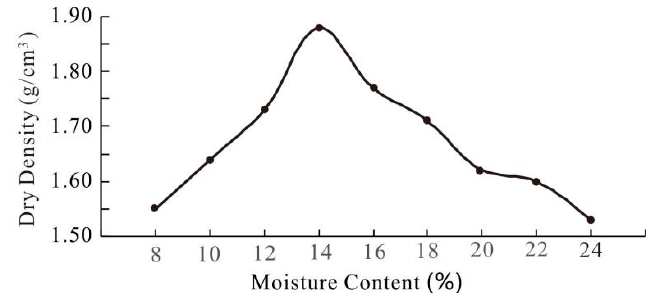
Figure 1. Particle size distribution of expansive soil.